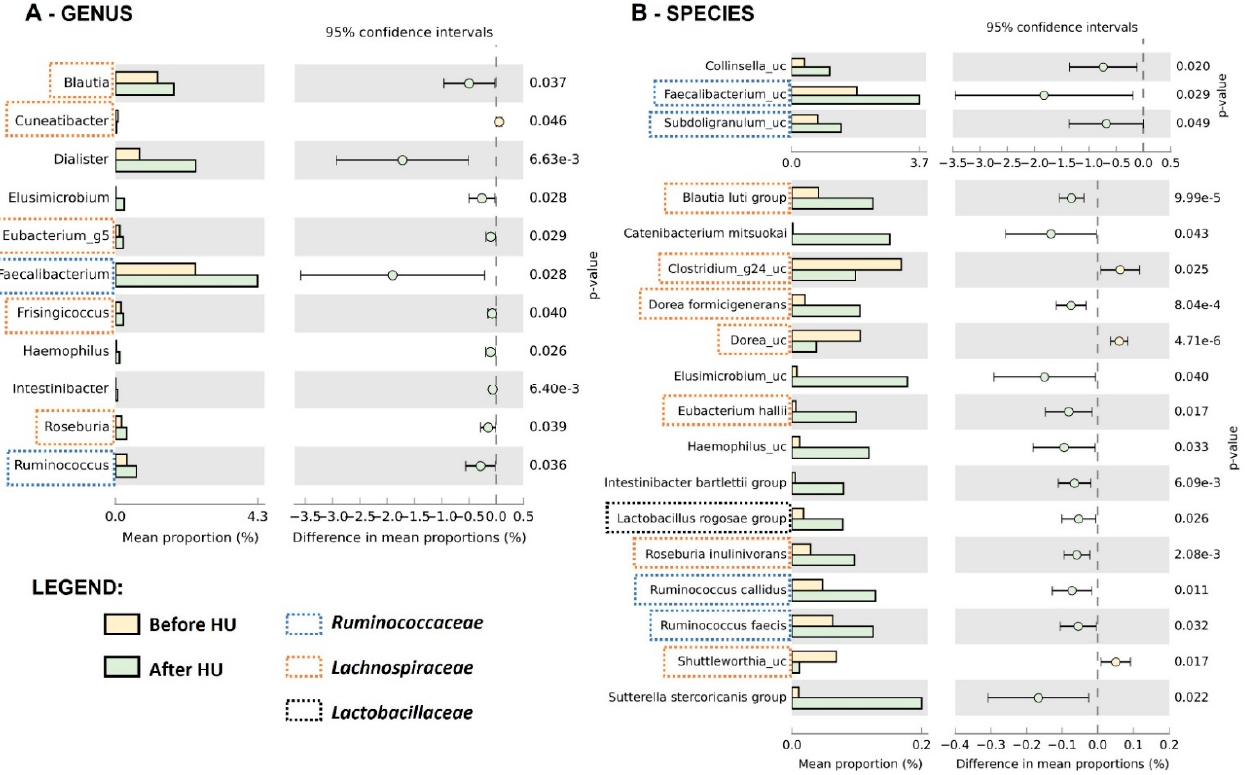
Figure 3. Distribution of the mean proportions of bacterial abundances between SCA children before ( n = 33) and after ( n = 33) HU treatment, regarding the taxonomic rank of ( A ) genus and ( B ) species. Besides the patient’s group, the legend indicates three relevant taxonomic families: Ruminococcaceae, Lachnospiraceae , and Lactobacillaceae . The results were filtered using a p -value lower than 0.05 with Welch’s t-test, the effect size of 0.05 threshold, and retaining unclassified reads in STAMP software.